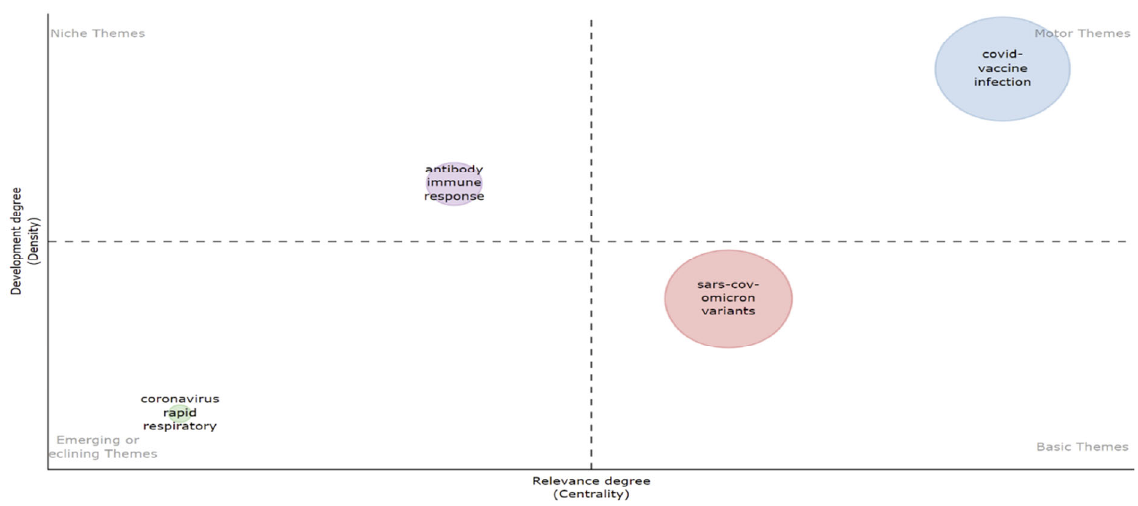
Figure 13. Thematic map representation of keywords in publications on the Omicron variant. Table 6. Thematic cluster measurements for keywords in publications on the Omicron variant.